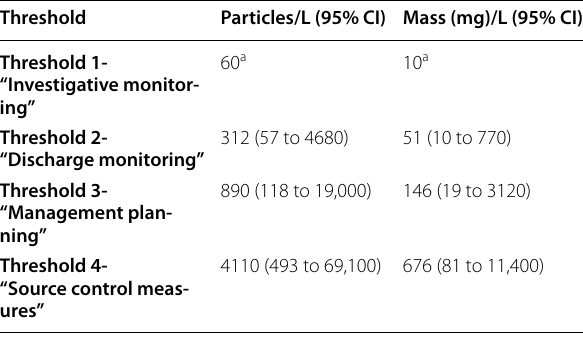
a Threshold 1 is the lower 95% CI of the HC5 calculated for Threshold 2, therefore confidence intervals cannot be reported for this threshold